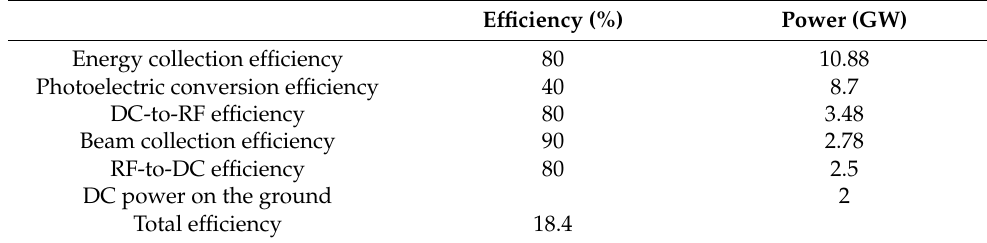
Table 5. Preliminarily efficiencies and power level for proposed SSPS.